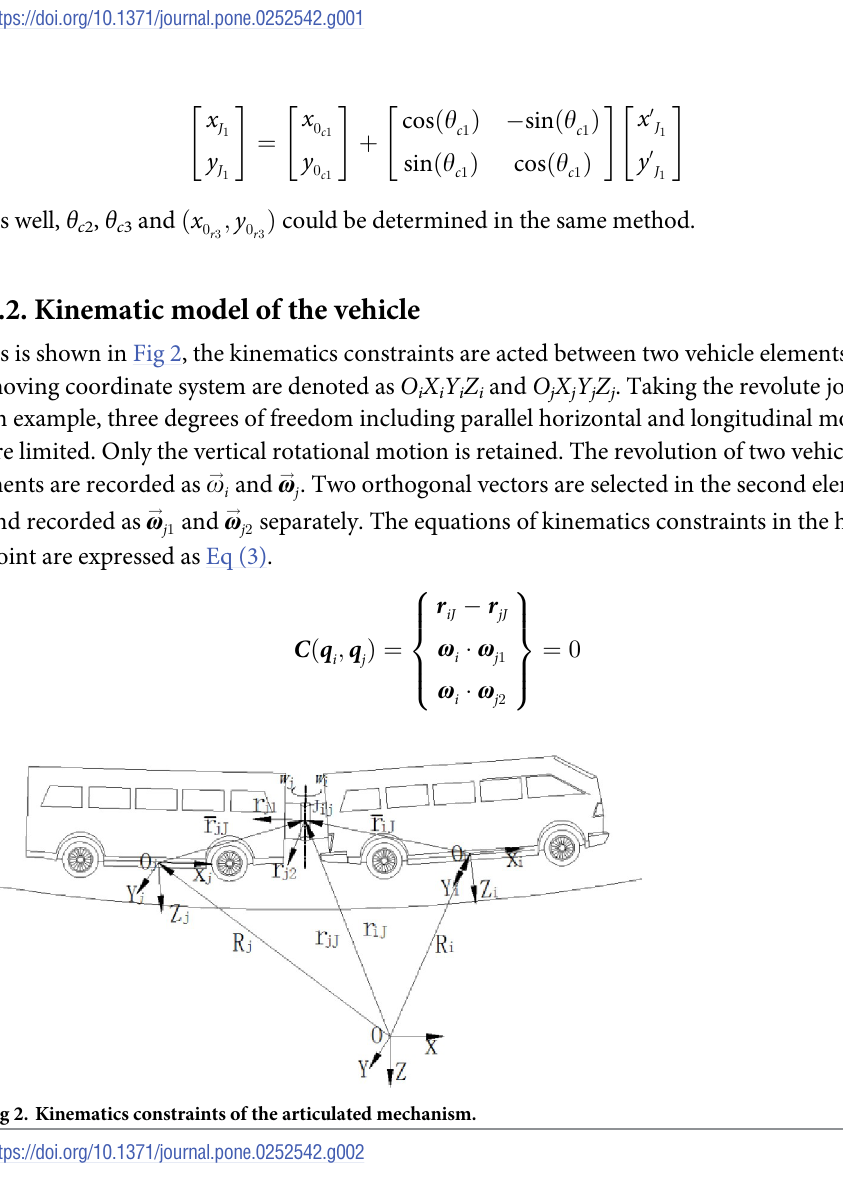
Fig 1. The expected position of each vehicle element along the track.